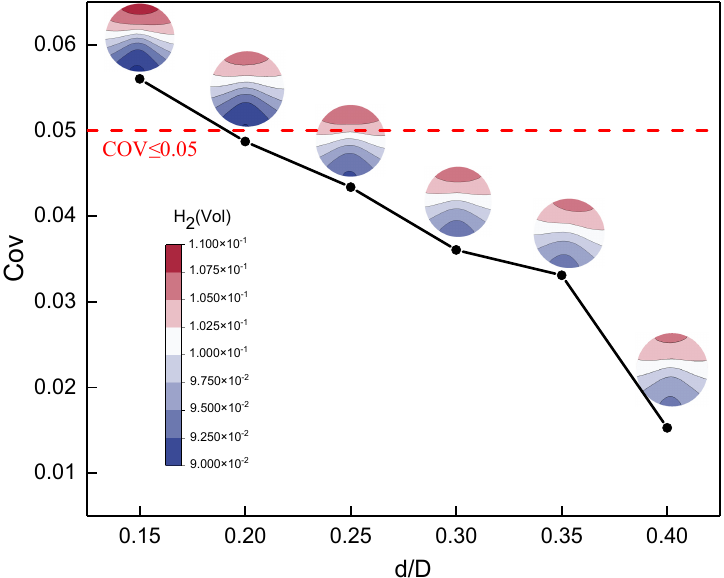
Figure 11. COV at the flow distance of z = 40 D (40th cross section) under different d / D.